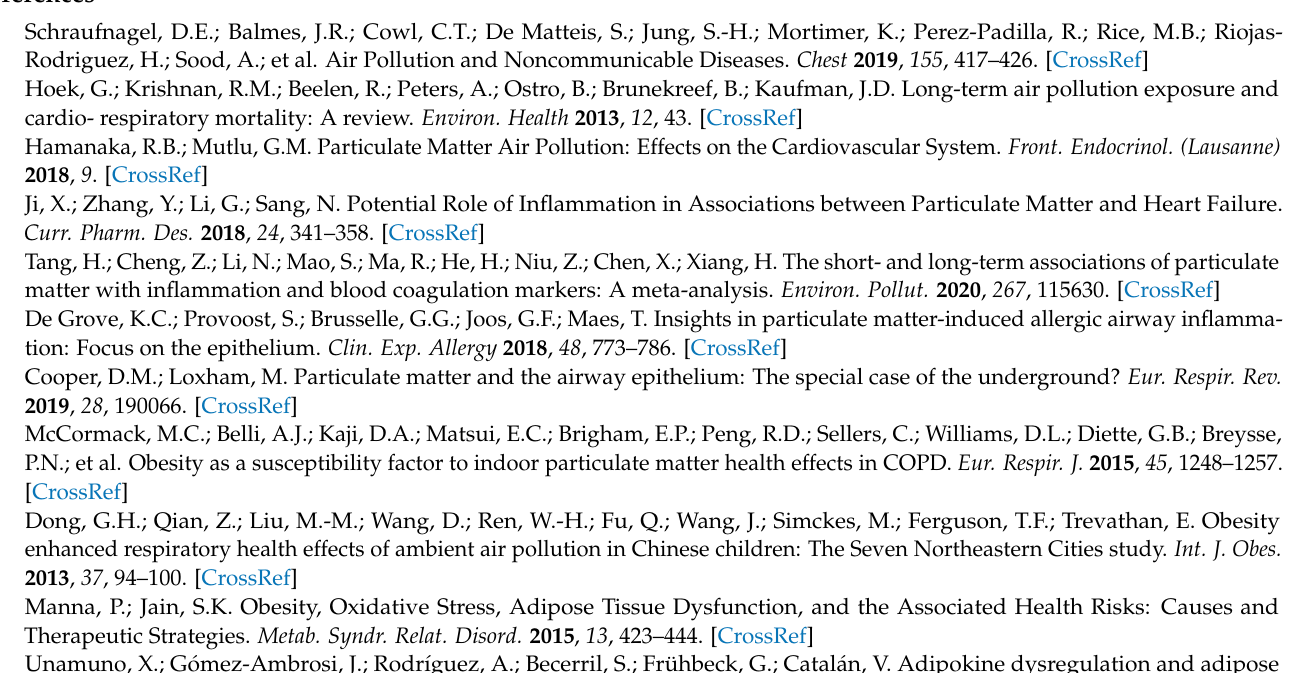
genes, Table S2: Associations between short-term exposure to PM 2.5 and clock methylation genes, Table S3: Significance of the interaction term testing the modifier role of BMI, on the association between PM exposure and clock methylation